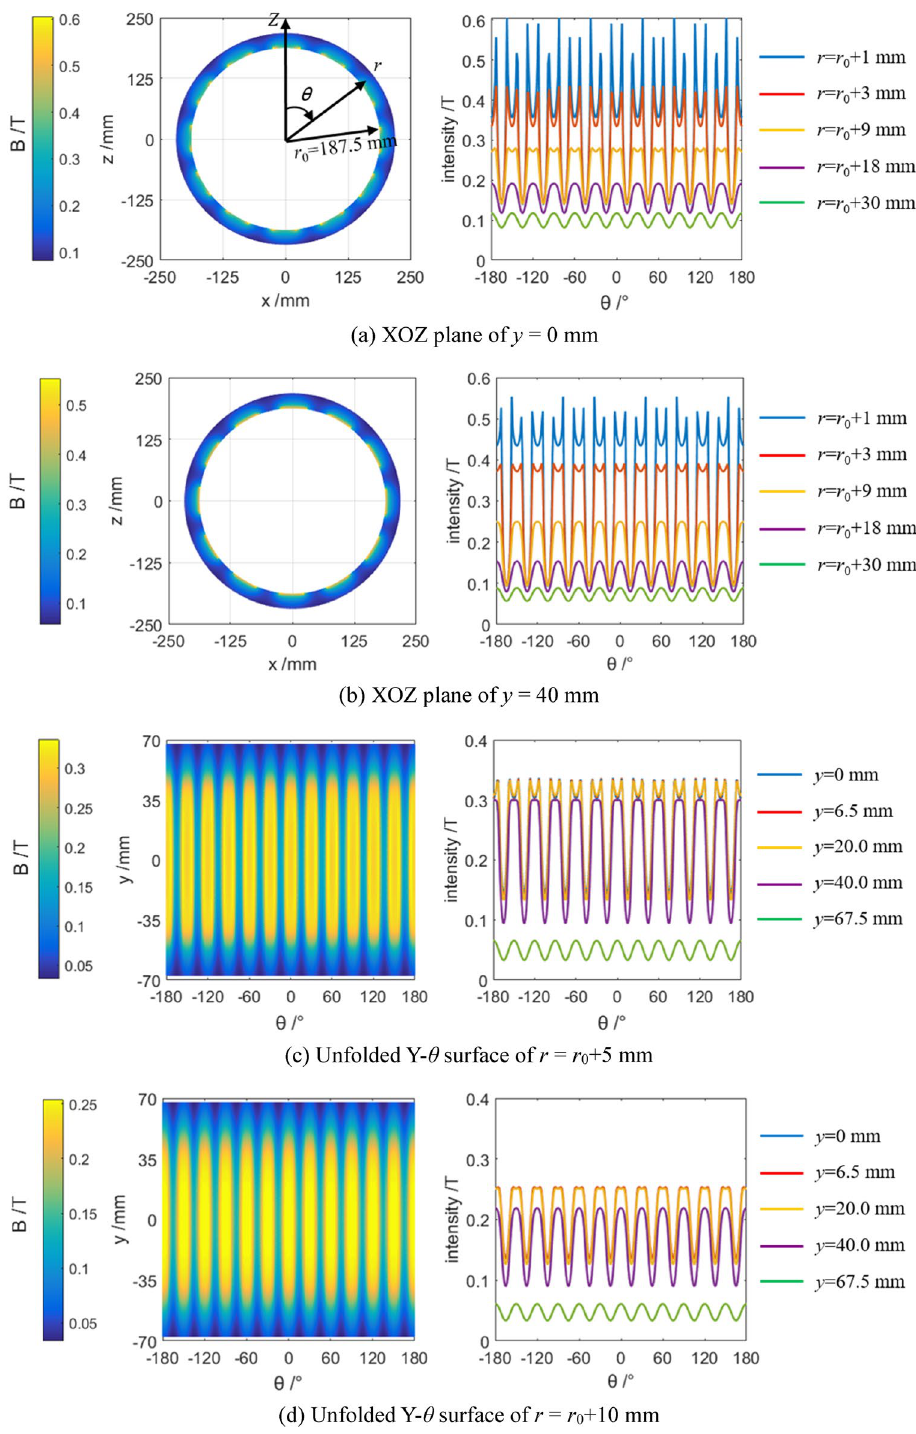
Figure 2. Simulated magnetic intensity B in the